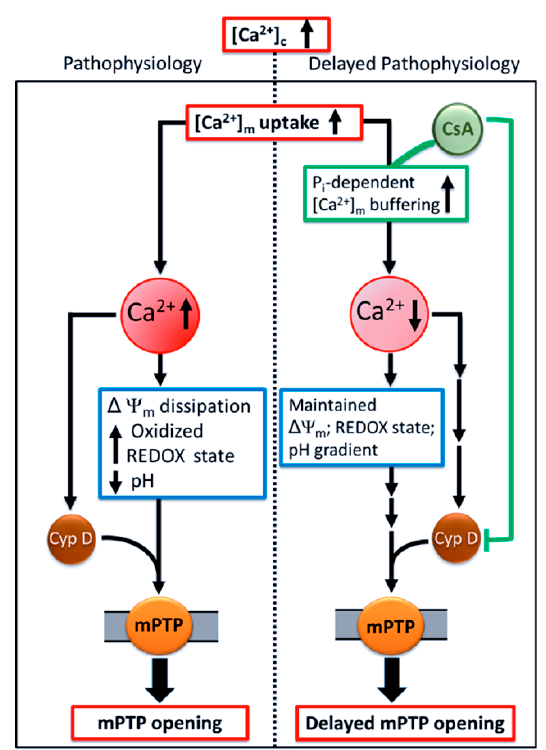
Figure 9. Schema of the potential mechanism by which CsA mediates delay in Ca 2 + -induced mPTP opening. Pathological conditions, like cardiac ischemia-reperfusion injury, leads to an increase in cytosolic Ca 2 + ([Ca 2 + ] c ). This in turn increases [Ca 2 + ] m and generation of reactive oxygen species (ROS), impairs respiration and substrate utilization, and leads to uncoupling of oxidative phosphorylation. Lower ∆Ψ m, oxidized redox state, and dissipation of the pH m gradient, together induces mPTP opening which triggers apoptosis. These detrimental consequences that underlie IR injury could be mollified by CsA, which allows the mitochondria to maintain their basal [Ca 2 + ] m via enhanced P i -dependent matrix Ca 2 + bu ff ering, in addition to, or through, Cyp D inhibition. Sustained low [Ca 2 + ] m maintains mitochondrial integrity and function and delays mPTP